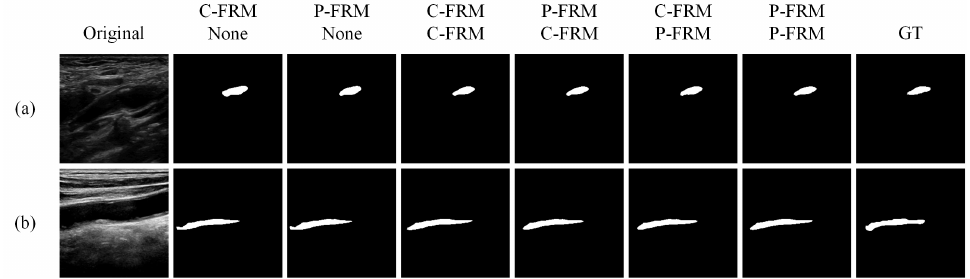
Figure 7. Qualitative comparison of carotid plaque segmentation results produced by different encoding and decoding blocks. ( a , b ) are partial segmentation